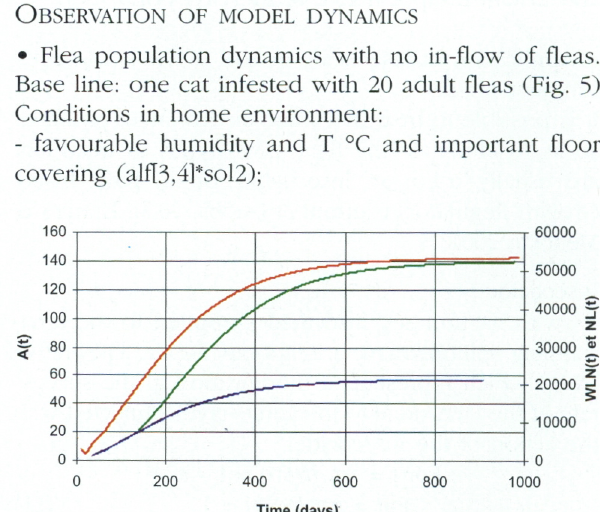
Fig. 5. - Flea population dynamics with no in-flow of